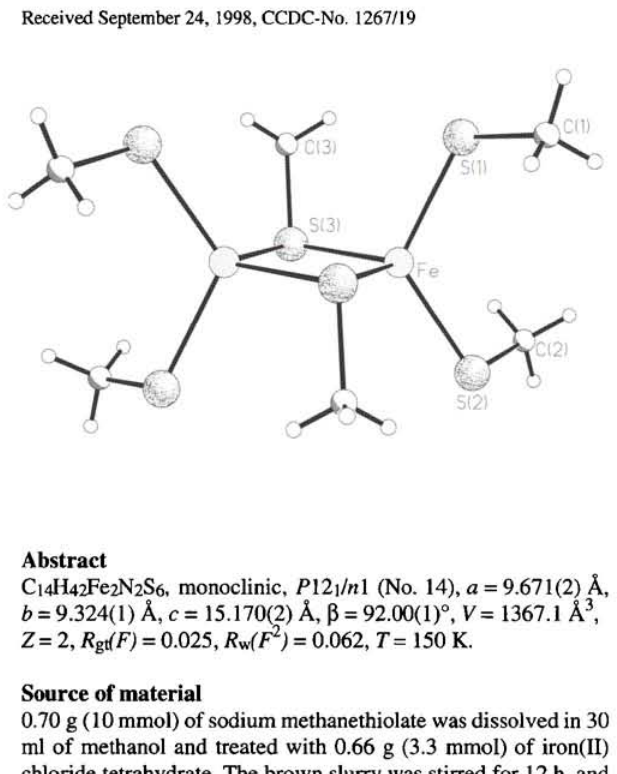
Table 2. Atomic coordinates and displacement parameters (in Â 2